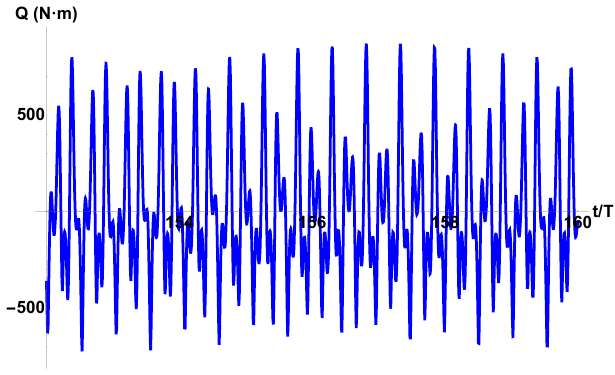
Fig. 9. The torque value fluctuation for symmetric rotor in monochromatic waves.